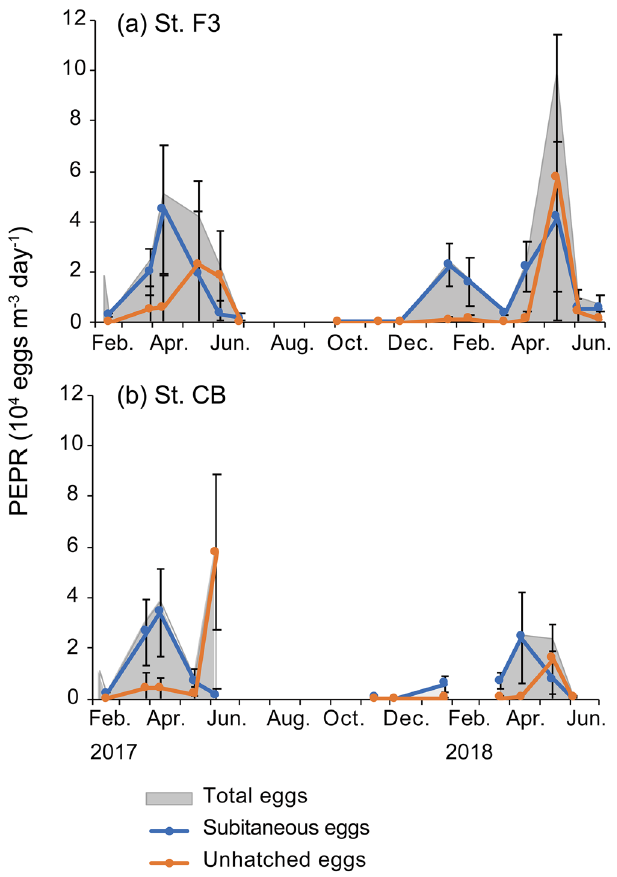
Figure 9. Seasonal changes in population egg production rate (PEPR) of Acartia omorii at St. F3 ( a ) and St. CB ( b ) from February 2017 through June